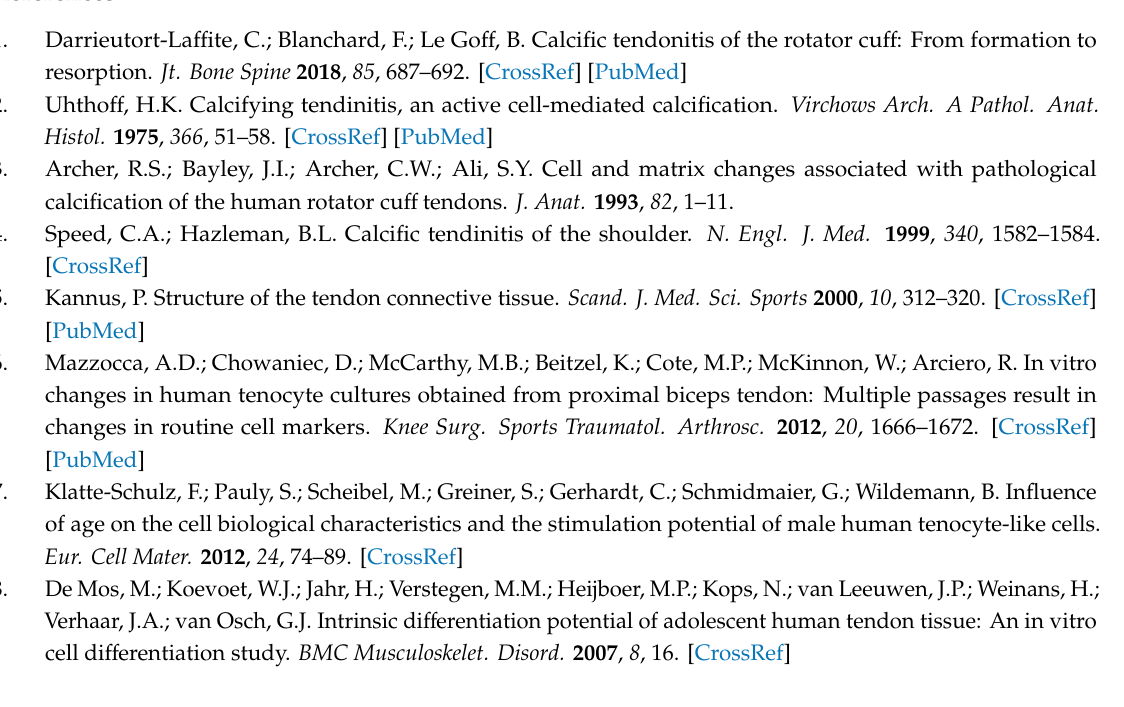
Figure S1: Histology and immunohistochemistry of a normal tendon, Figure S2: Characterization of tenocyte-like cells, Table S1: Primers used for quantitative PCR, Table S2: Proteomic analysis of calcium deposits from 5